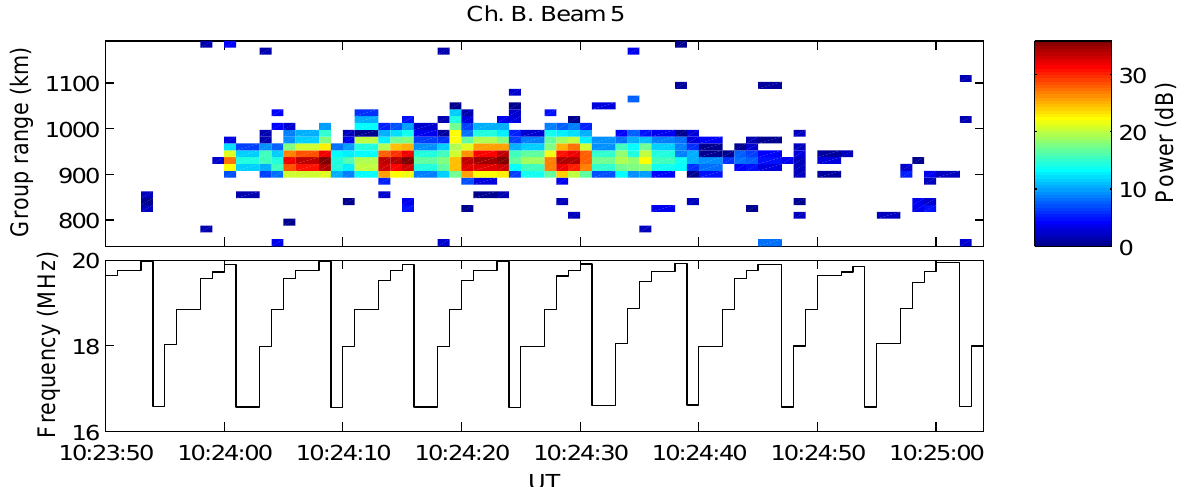
Fig. 3. Sample of radar backscatter power observations during a HF pump cycle. The top panel shows the backscatter power (dB) and the bottom panel the radar frequency (MHz). The HF pump was turned on at 10:24:00 UT and off at 10:24:30 UT on 5 November 2002. The AFAI backscatter can be seen between ranges of 900 and